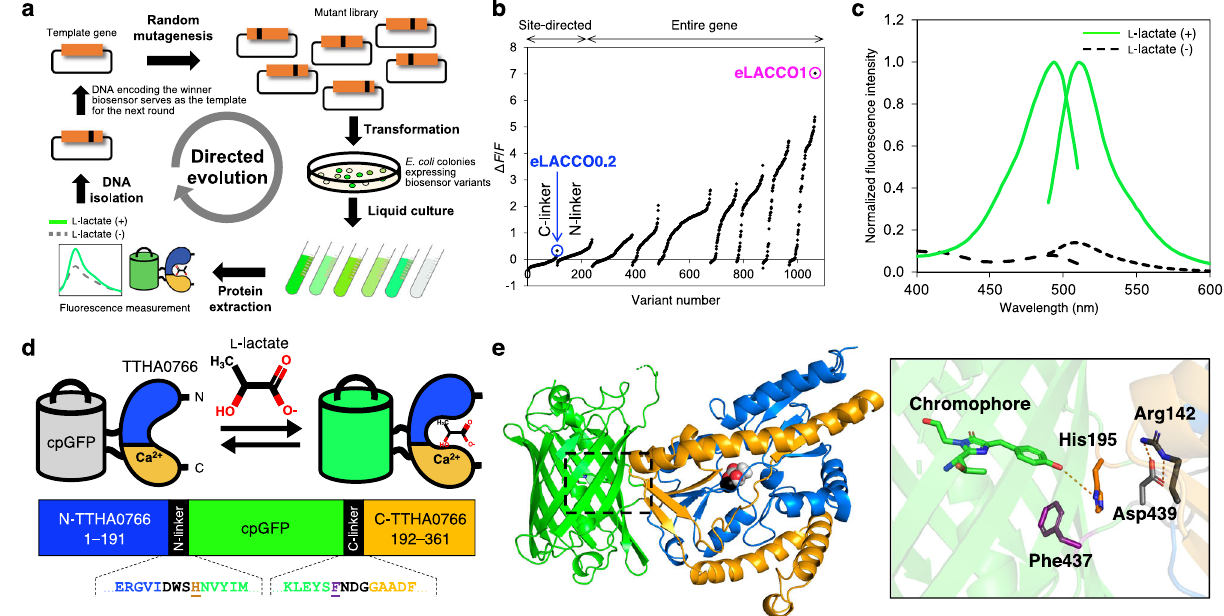
Fig. 1 Development of a genetically encoded L -lactate biosensor, eLACCO1. a Schematic of the directed evolution work fl ow. Speci fi c sites (i.e., the linkers) or the entire gene of template L -lactate biosensor genes were randomly mutated and the resulting mutant library was used to transform E. coli . Bright colonies were picked and cultured, and then proteins were extracted and Δ F / F upon addition of 10 mM L -lactate was determined. The variant with the highest Δ F / F was used as the template for the next round. b Δ F / F rank plot representing all proteins tested during the directed evolution. For each round, tested variants are ranked from lowest (negative responses indicate inverse response) to highest Δ F / F value from left to right. The fi rst round of evolution used a library in which residues of the C-terminal linker were randomized. Screening of this library led to the discovery of eLACCO0.2 with a direct response ( fl uorescence increase upon binding) to L -lactate ( Δ F / F = 0.3) while the template eLACCO0.1 decreased the fl uorescence intensity (inverse response) in response to L -lactate. Nine rounds of the evolution led to eLACCO1 indicated with a magenta circle. c Excitation and emission spectra of eLACCO1 in the presence and absence of 10 mM L -lactate. Excitation and emission peak is at 494 and 512 nm, respectively. d Schematic representation of eLACCO1 and its mechanism of response to L -lactate. Linker regions are shown in black and the two “ gate post ” residues 5 in cpGFP are highlighted in dark orange (His195) and purple (Phe437). e Crystal structure of eLACCO1. Right panel represents a zoom-in view around the chromophore. Source data of b , c are provided as a Source Data fi fl uorescence change ( Δ F / F = 4, at 480 – 510 nm) (Fig. 2b, d). A similar trend has been observed for some red fl uorescent